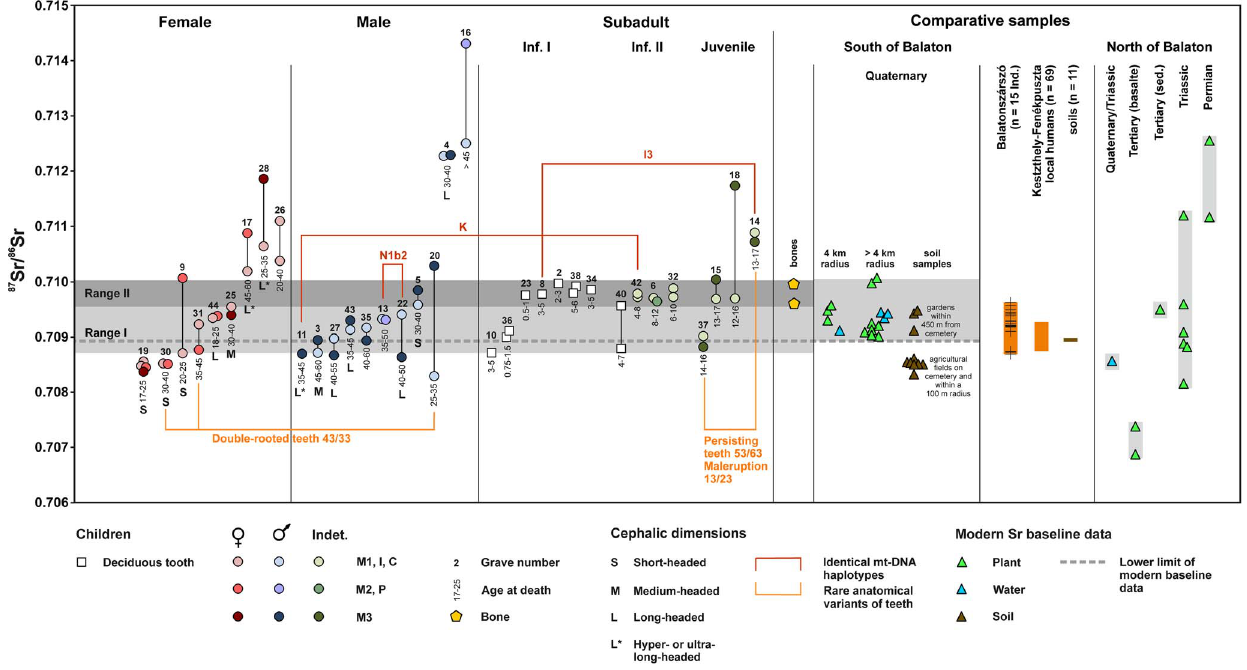
Figure 4. 87 Sr/ 86 Sr ratios of human tooth enamel and bone from the cemetery at Szo´la´d in comparison to modern vegetation, water, and soil samples from localities within a 12 km radius and from major geological units in the hills north of Lake Balaton. Ranges I and II are derived from the data distribution of the tooth enamel of the children, illustrated in the kernel density plot (Figure 5). The data from Kestzthely-Fene´kpuszta and Balatonsza´rszo´ were taken from [79] and [57] respectively (graphics: C. Knipper).